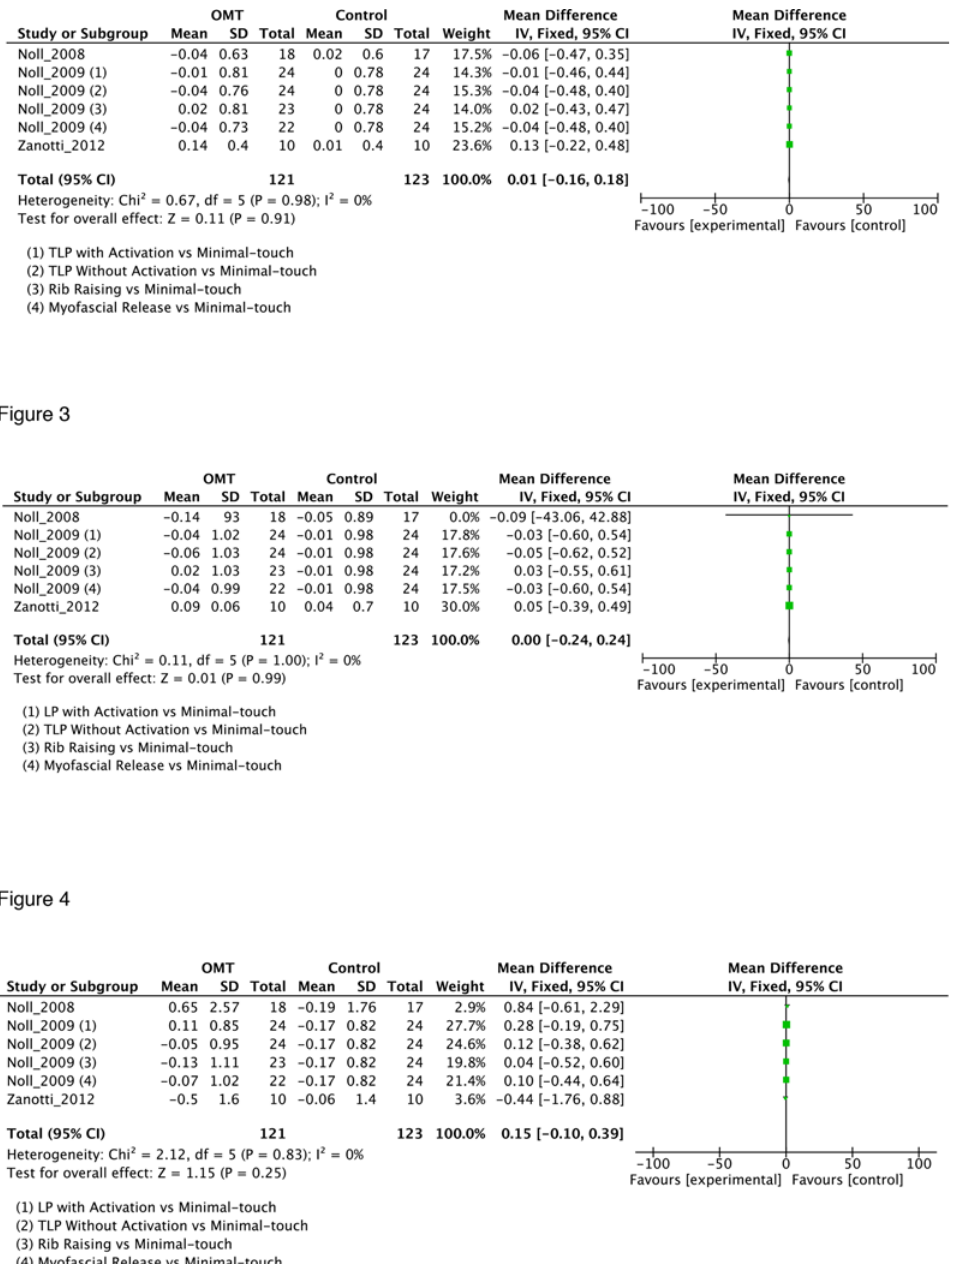
Fig 2. Forest plot of comparisons, OMT for COPD parameters. Outcomes: A, forced expiratory volume in the first second (FEV1); B, forced vital capacity (FVC) and C, residual volume (RV). CI, confidence interval; SD, standard deviation.